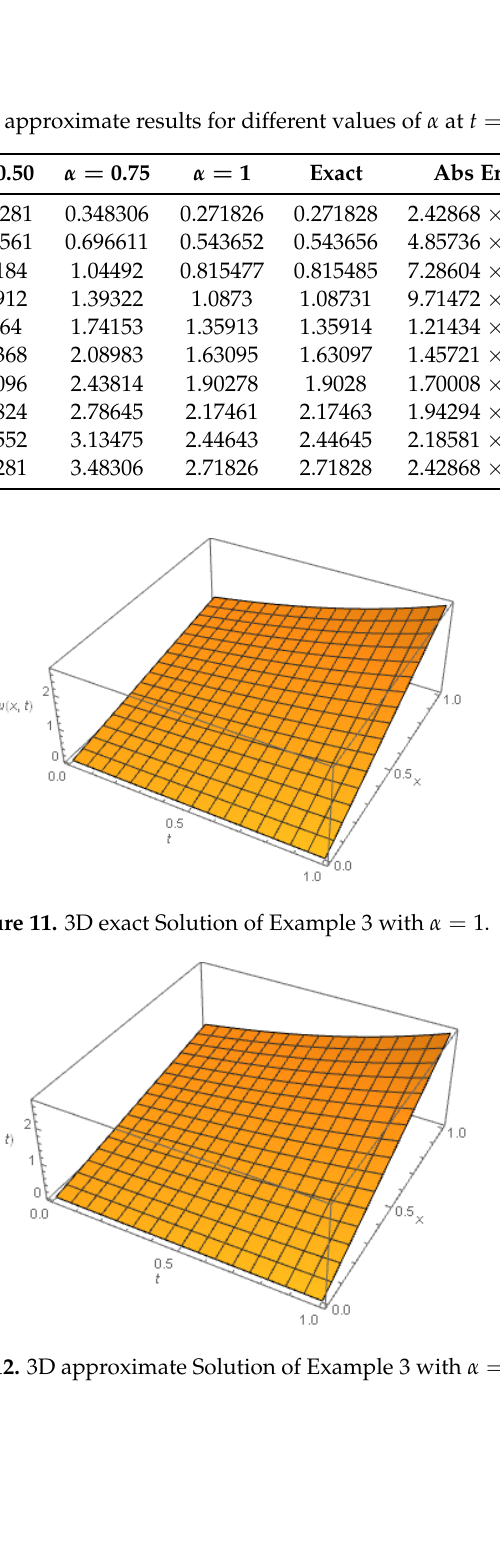
Figure 3:3D Solutions of example3 with di⁄erent